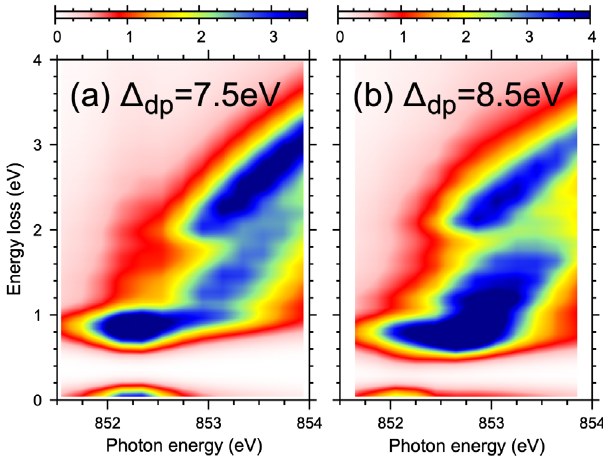
FIG. 8. The Ni L 3 RIXS spectra of LaNiO 2 calculated for 7 . 5 eV and (b) Δ 8 . 5 eV. The spectral broadening (a) Δ dp ¼ dp ¼ is considered using a Gaussian of 100 meV